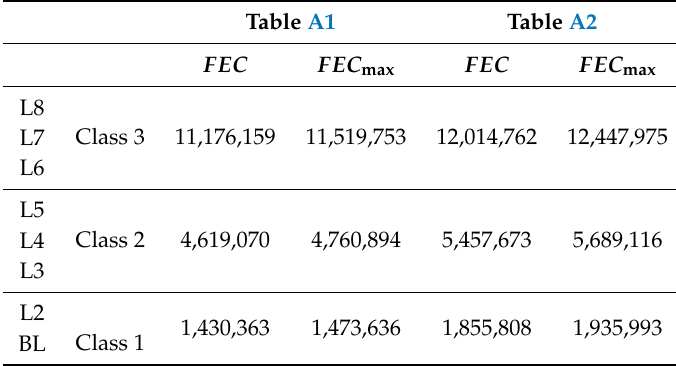
Table A5. Cumulative transmission cost of the three classes based on the respective underlying FEC allocation rate, e.g., Table A1 (best case) and Table A2 (worst case).